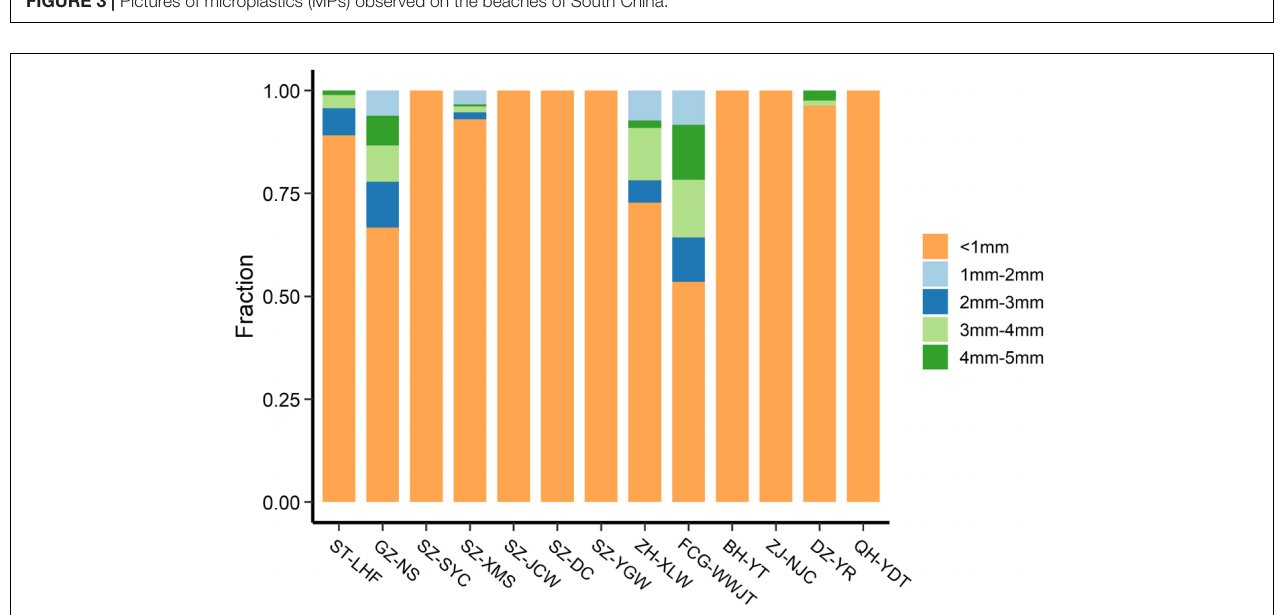
FIGURE 3 | Pictures of microplastics (MPs) observed on the beaches of South China.